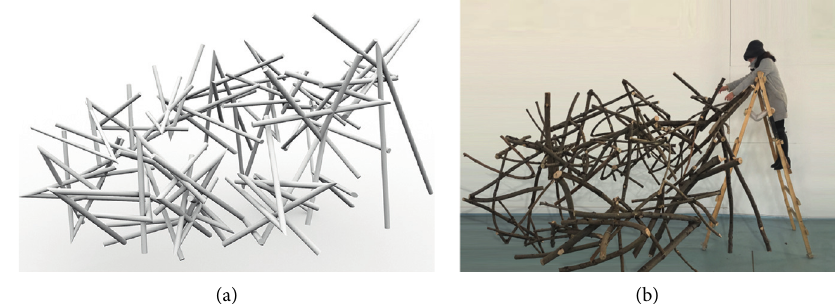
Figure 17: Digital simulation and physical